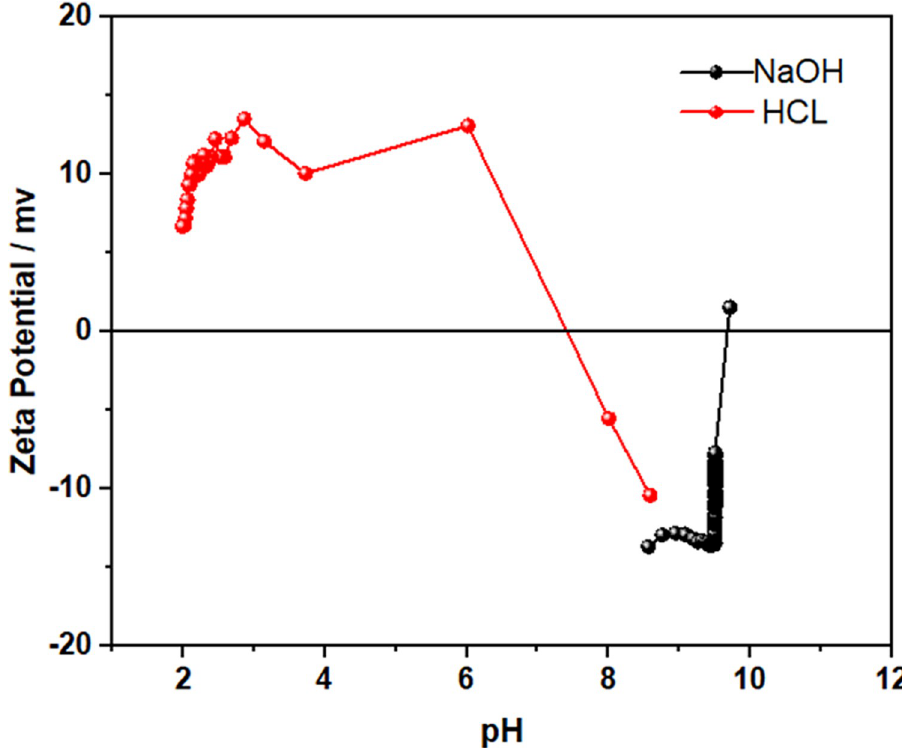
Fig 2. Zeta Potential of buriti oil nanoencapsulated in porcine gelatin under different pH conditions.